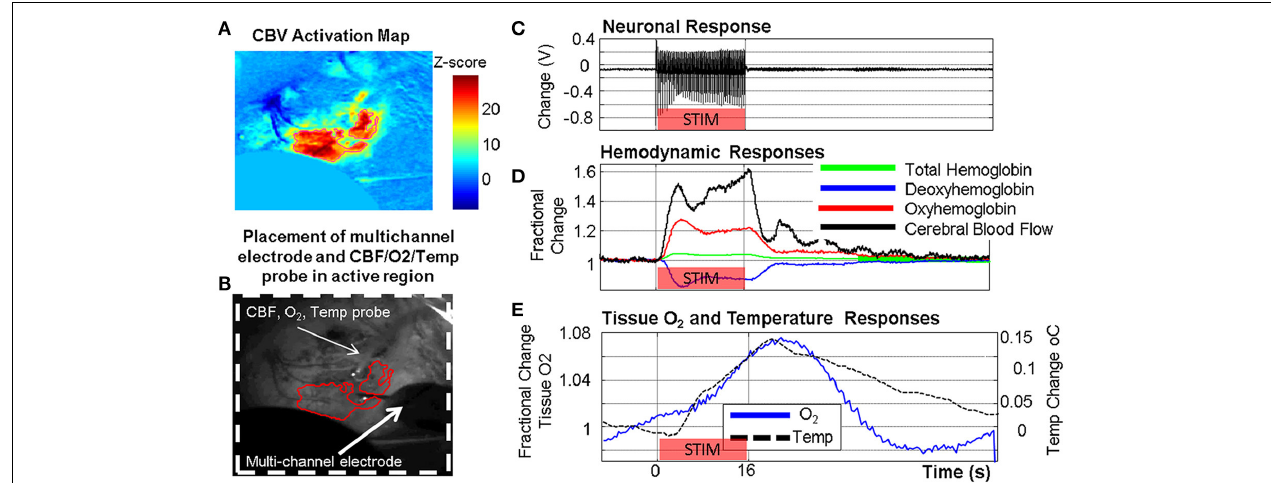
FIGURE 5 | Example of concurrent multi-modal measurement of neurovascular function developed in our laboratory showing simultaneously acquired neuronal, metabolic and vascular responses in the somatosensory cortex following a 16s stimulation of the contralateral whisker pad. (A) Cerebral blood volume (CBV) activation map